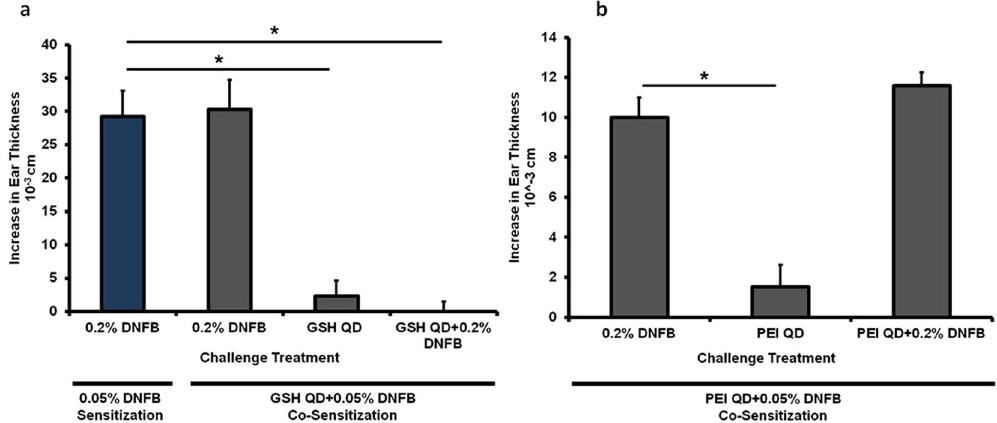
Figure 3. Co-sensitization with 0.05% DNFB + GSH QD and 0.05% DNFB + PEI QD. ( a ) Mice were co- sensitized to either 0.05% DNFB alone or 0.05% DNFB + GSH-QD. Various combinations were tested in the challenge phase. The co-sensitized mice exhibited a normal ear swelling response when challenged with 0.2% DNFB alone which was comparable to the ear swelling levels measured on mice sensitized with only 0.05% DNFB (blue bar, expected swelling response). Mice did not exhibit any ear swelling response to GSH-QD alone indicating that they were not sensitized to GSH-QD. When GSH-QD were combined with 0.2%